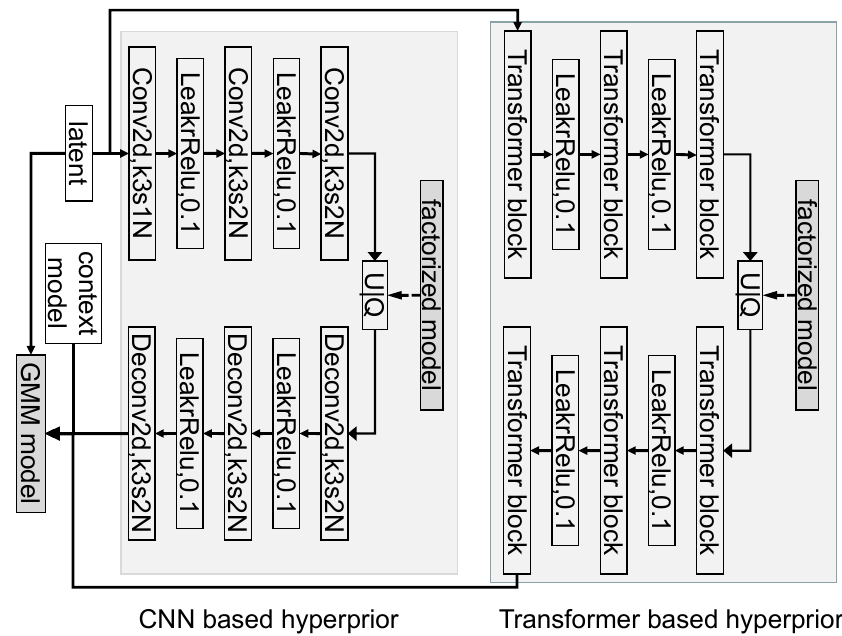
Figure 4. This is the entropy model used in the proposed